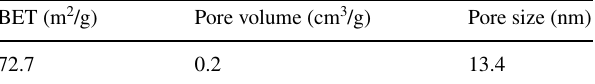
2 NPs, ZnTiO 2 and